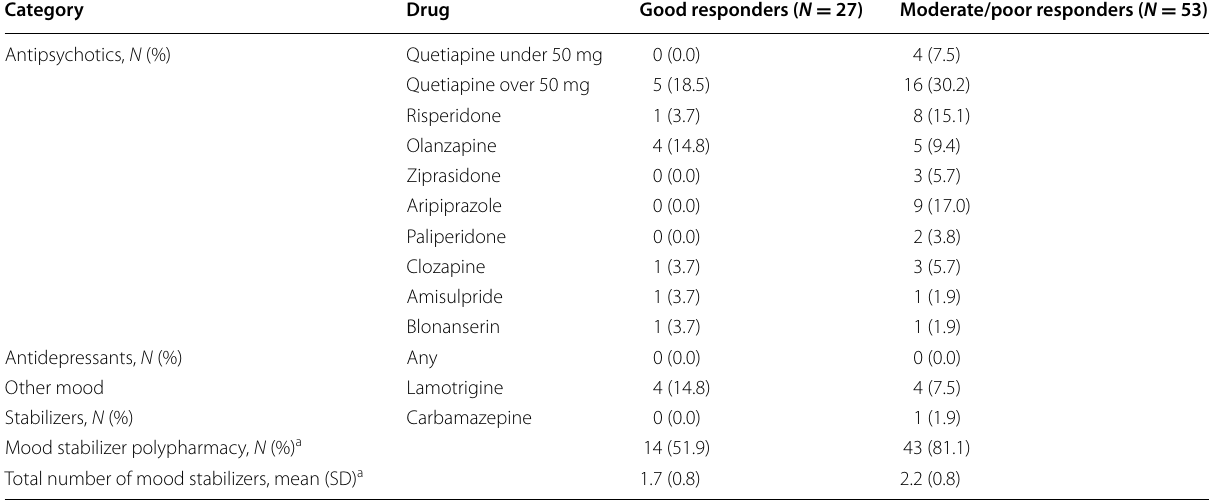
At the time of the assessment of treatment response a Including index medications, atypical antipsychotics, and other mood stabilizers; for quetiapine, daily dose of 50 mg or less which is usually applied for insomnia control was excluded